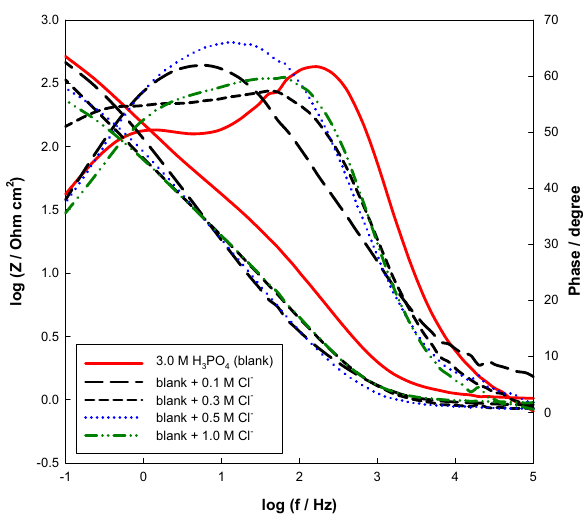
Figure 8. Bode plots of Mo in 3.0 M H 3 PO 4 containing different concentrations of Cl − at 298 K.